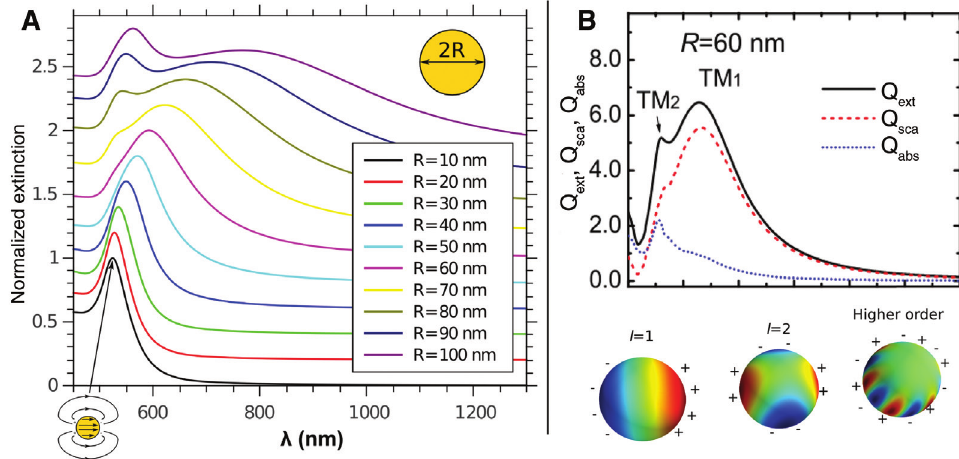
Figure 1: (A) Extinction spectra of gold nanospheres of increasing radius R in water, computed with the Mie theory; (B) extinction, scatter- ing and absorption spectra of a 60-nm-radius silver nanosphere in air, together with the distribution of the surface charges for the dipolar, quadrupolar and an arbitrary higher order mode [5]. © IOP Publishing. Figure 1 (B top) reprinted from S. Hayashi and T. Okamoto, Journal of Physics D: Applied Physics, vol. 45. p. 433001, 2012. Reproduced by permission of IOP Publishing. All rights